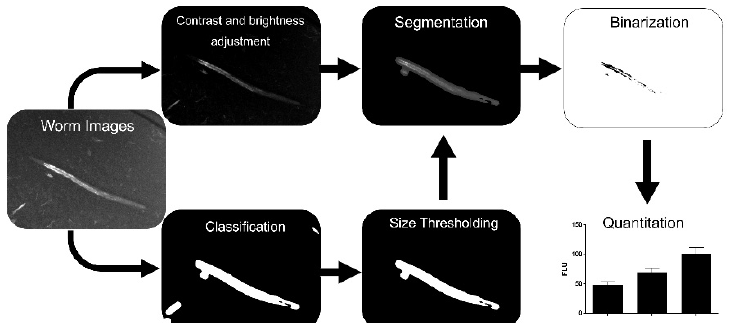
Figure 1. Workflow of the image processing approach. After fluorescence image acquisition, machine learning classification is performed followed by size thresholding to eliminate false positive areas and manual quality control. Each resulting mask is multiplied with its respective contrast- and brightness- adjusted image. Fluorescent areas are quantified in the segmented images after binarization.